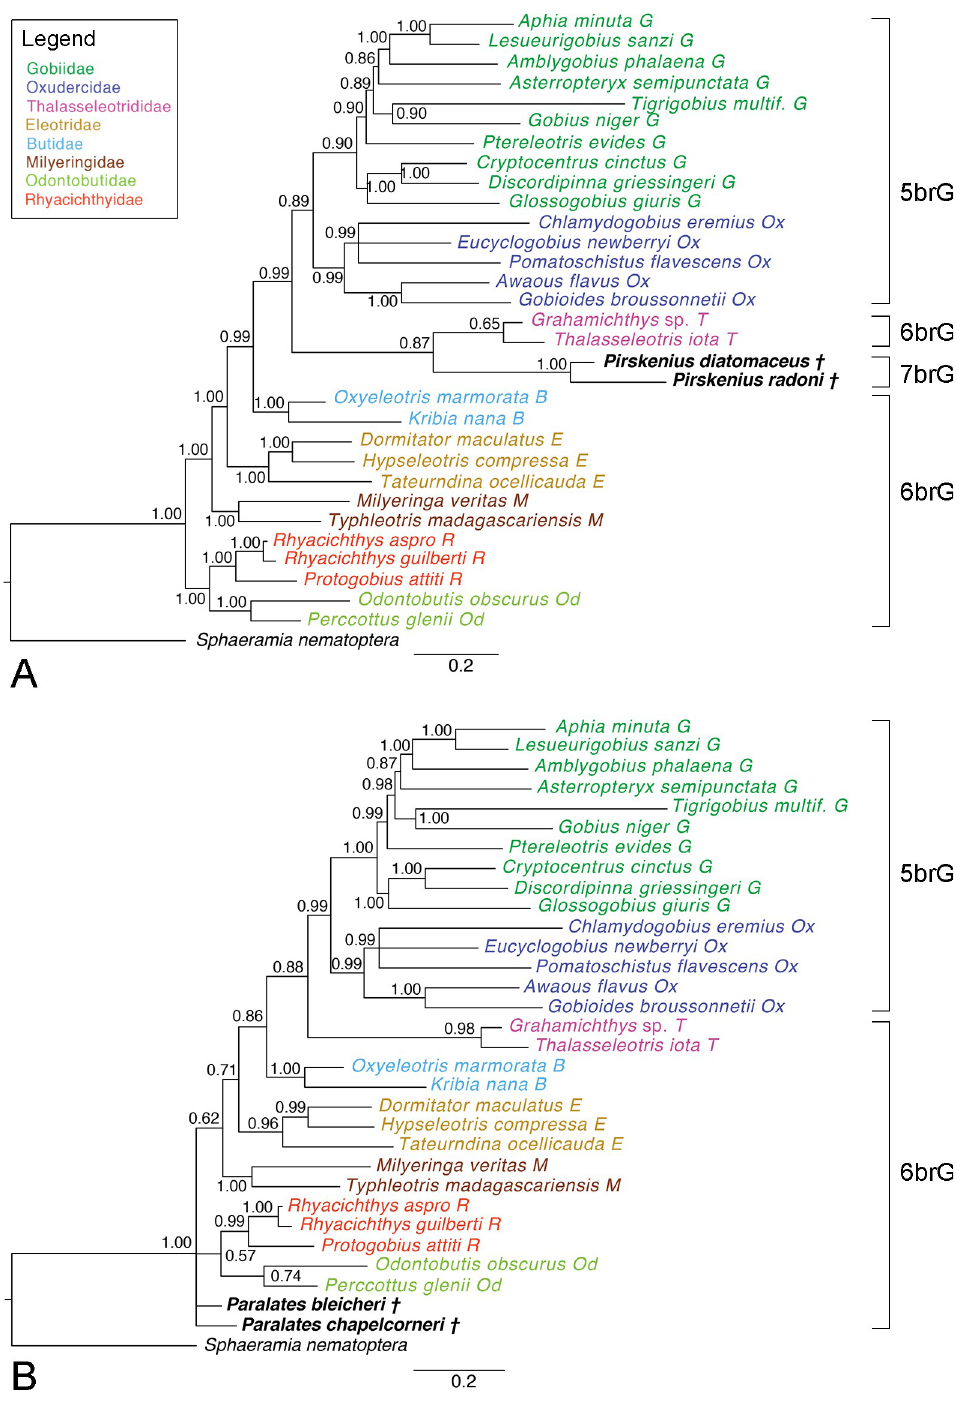
Fig 8. 50% MRC Bayesian trees with posterior probabilities based on the total-evidence dataset. A † Pirskenius diatomaceus and † P . radoni were added to the extant species (ASDSF = 0.017673). B † Paralates bleicheri and † Pa . chapelcorneri were added to the extant species (ASDSF = 0.006995). Scale bars, average number of substitutions per site respectively character changes per character.